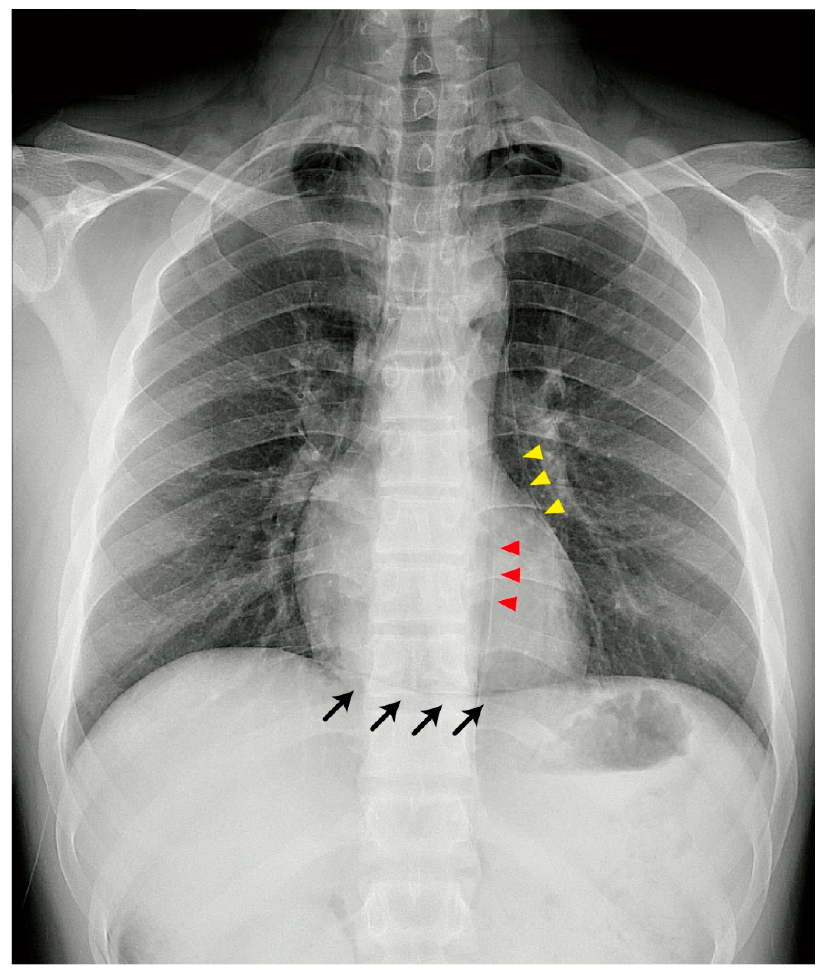
Figure1. ChestX-rayshowsgrosssubcutaneousemphysemaovertheneckandpneumomediastinumwith a continuous diaphragm sign (black arrows). The gas outlining the mediastinum, aorta (red arrowheads), and heart (yellow arrowheads) extends into the